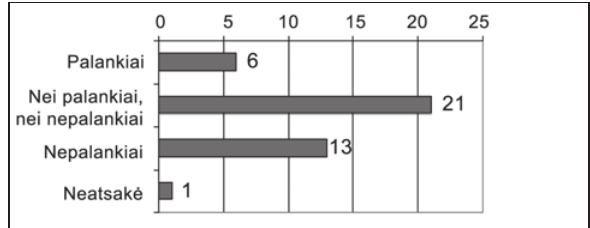
15 pav. Visuomenës dalyvavimo miesto plëtros planavimo Fig 15. Estimation of public involvement in urban development planning process according to the experts’ poll results, 2005